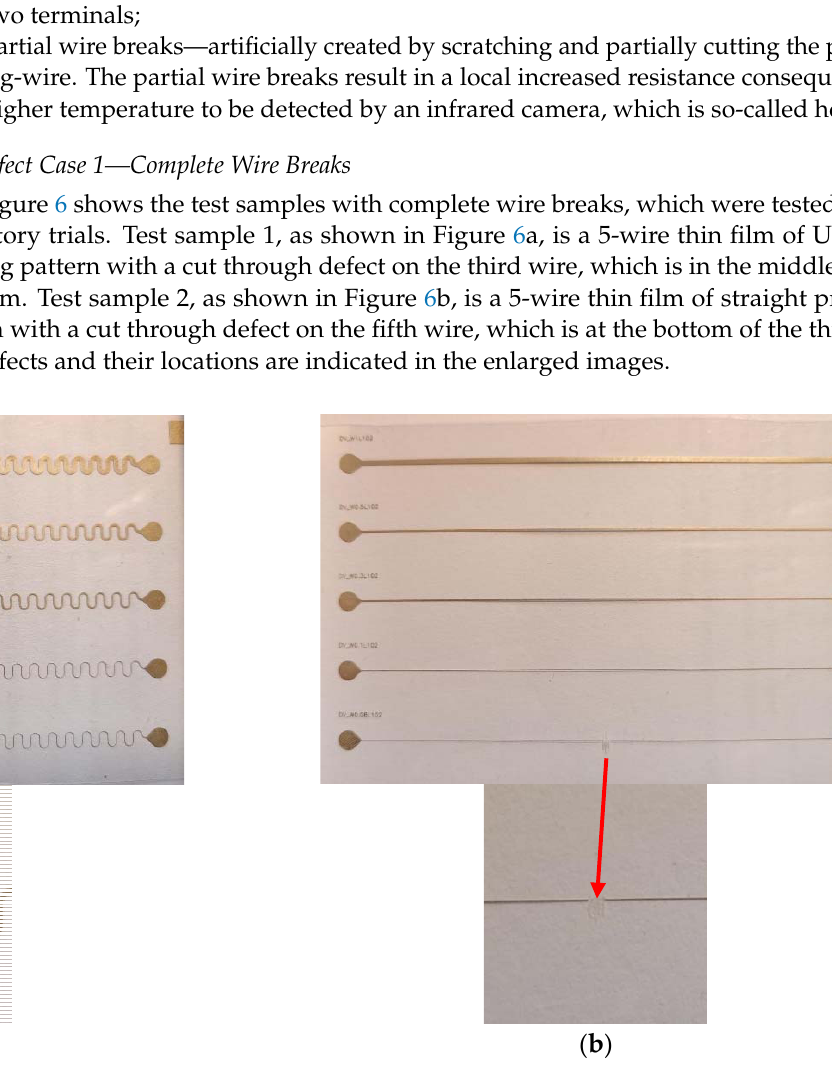
Figure 5. Test sample installed on test jig.